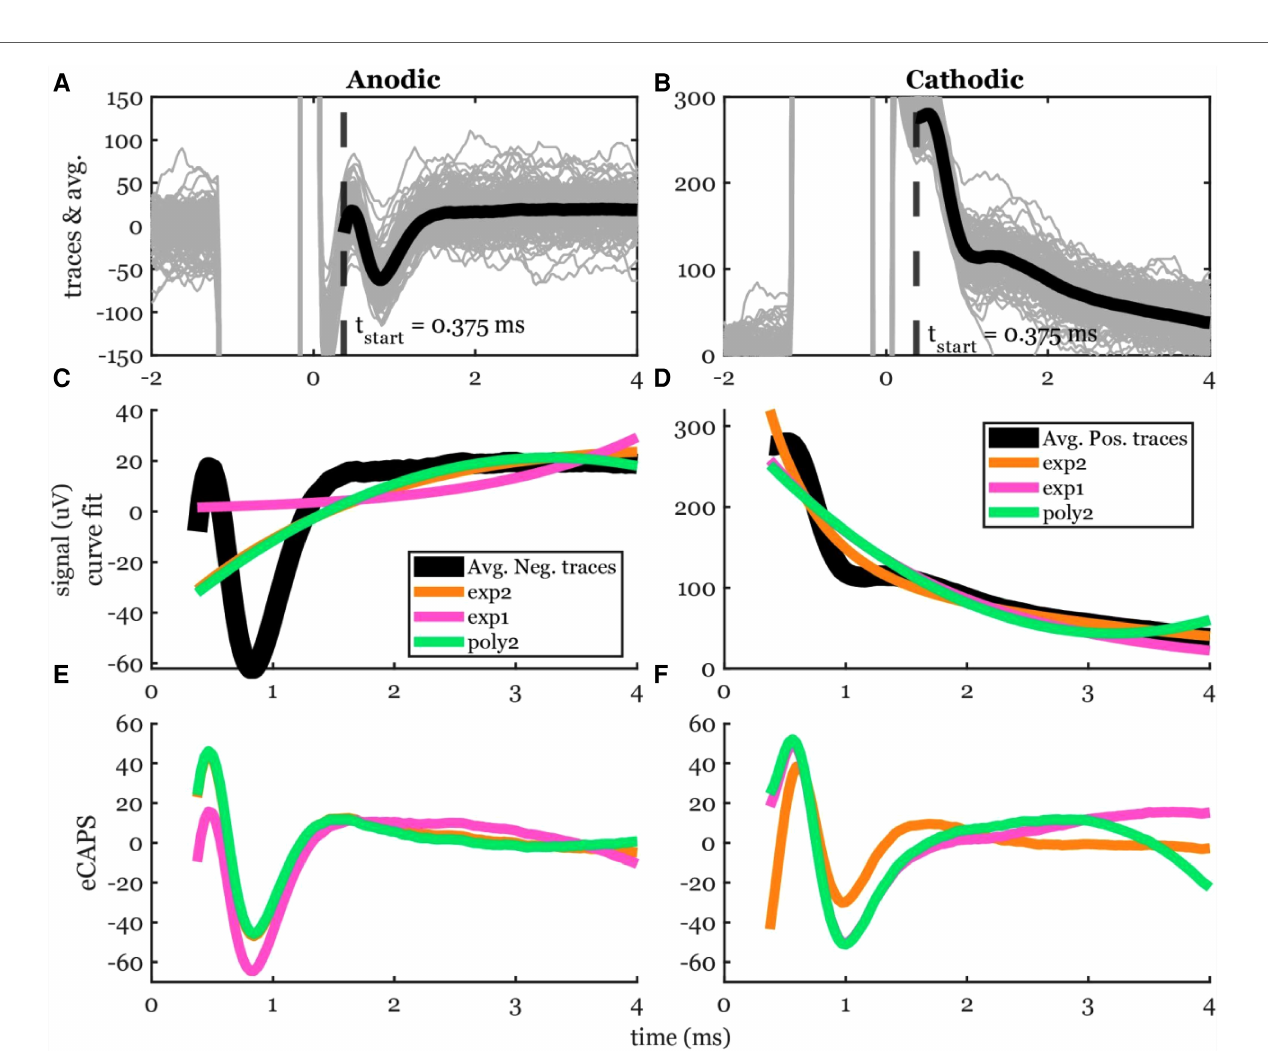
FIGURE 4 Stimulation artifact removal steps demonstrated in a 5-mA stimulation of participant #2. ( A,B ) Raw traces (gray lines) fi ltered with the median fi lter grouped into cathodic and anodic classes and averaged (black lines) separately. ( C,D ) Three curves (exp2: double exponential, exp1: single exponential, and poly2: 2nd order polynomial) were fi t to the average signal. The time window for the artifact removal algorithm was [0.375, 4] ms. ( E,F ) The resulting ECAP after subtracting the estimated stimulation